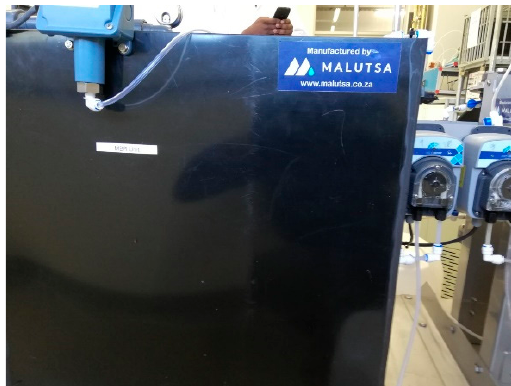
Figure 3. The MBR unit used.